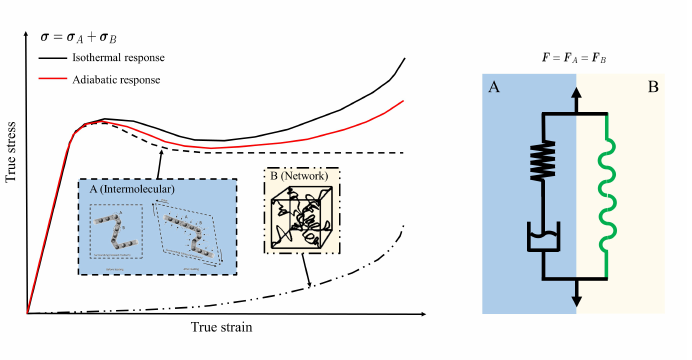
Figure 9. Schematic stress–strain representation of intermolecular and network resistances ( left ) and the corresponding rheological model ( right